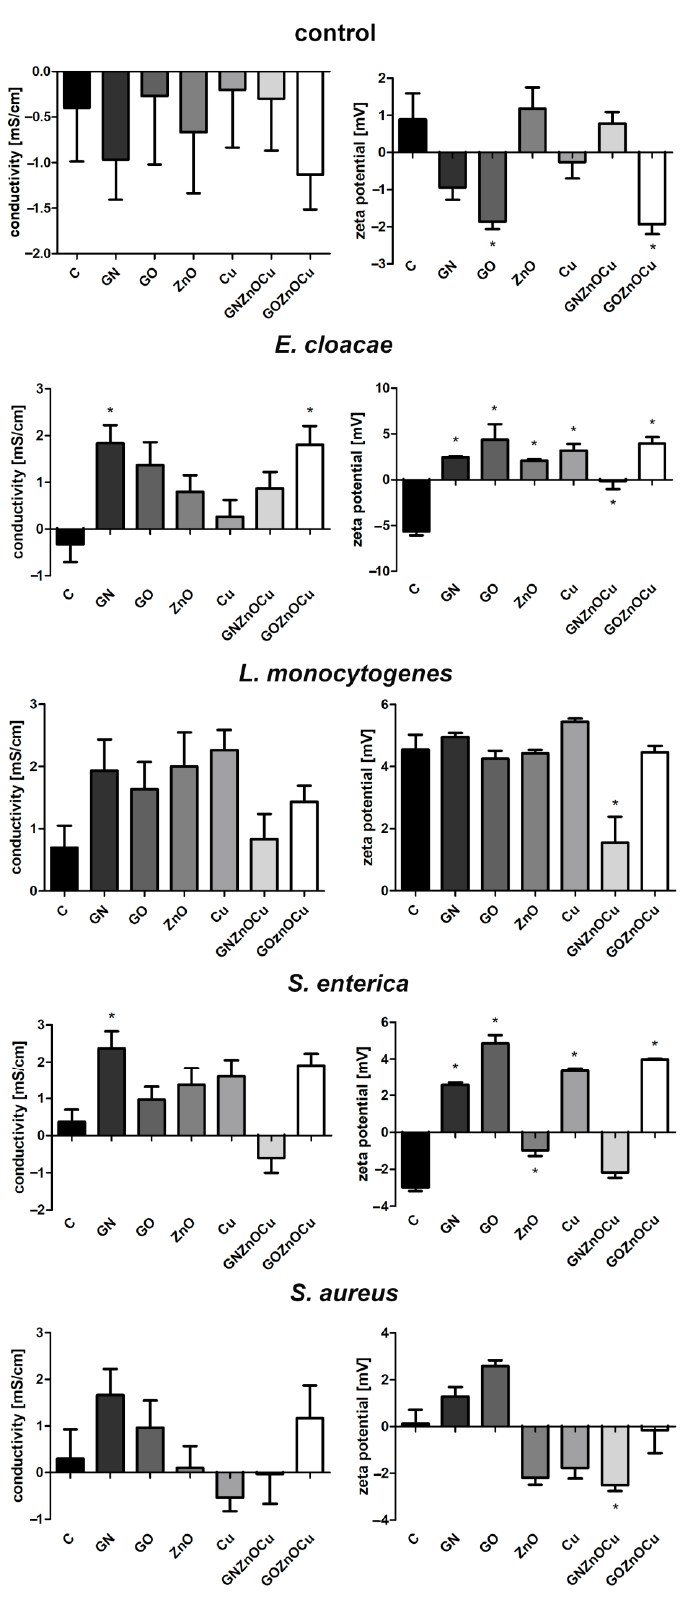
Figure 6. Conductivity [mS/cm] and zeta potential [mV] of bacteria species after treatment with nanomaterials. Control values are nanosuspensions without bacteria cells. C signifies the control samples, and the results are mean values ± standard deviation. “*” symbols indicate statistically significant differences in comparison to the control. The results are the difference between 0 h and 24 h of incubation with appropriate